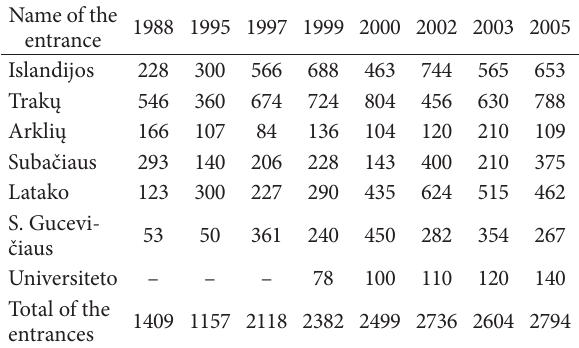
Table 2. Dynamics of traffic in Vilnius Old Town per average hour (1988–2005)